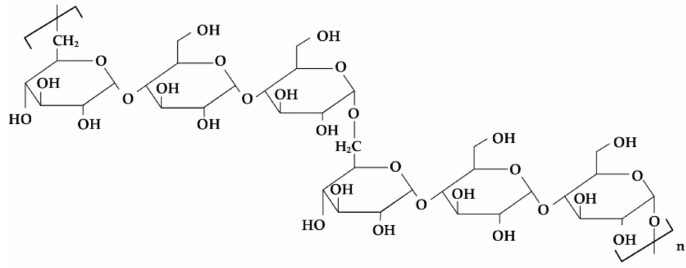
Figure 6. Schematic illustration of pullulan